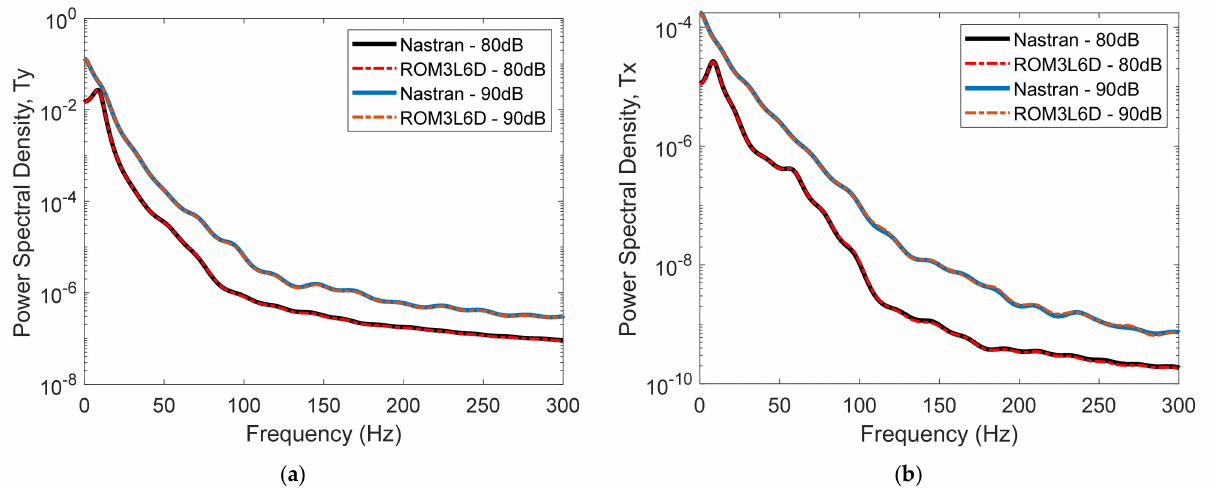
Figure 3. Power spectral densities of the deflections of the tip of the cantilevered curved beam Nastran and ROM predictions for uniformly distributed pressure bandlimited in [0, 100] Hz and with magnitudes of 80 and 90dB. ( a ) Transverse, ( b )